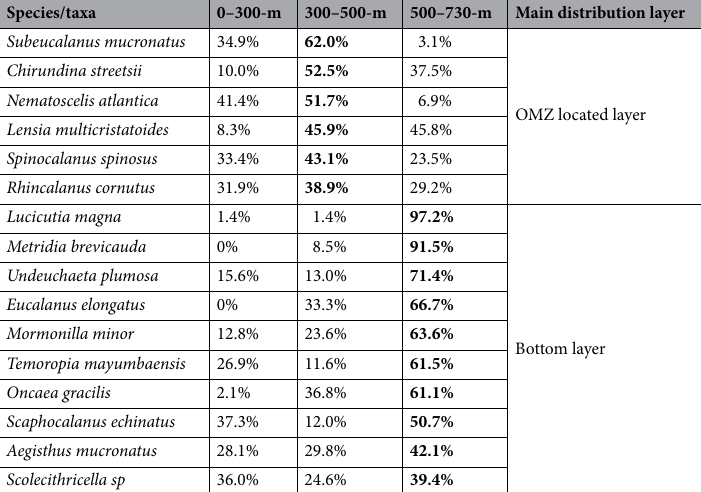
Table 1. The quantity percentage in different sampling layers of zooplankton species/taxa mainly distributed in the OMZ located layer and bottom layer in the Caroline Seamount area on June 2 to 3, 2019. The bold font indicates the maximum value of the quantity percentage in different sampling layers of zooplankton species/ taxa.